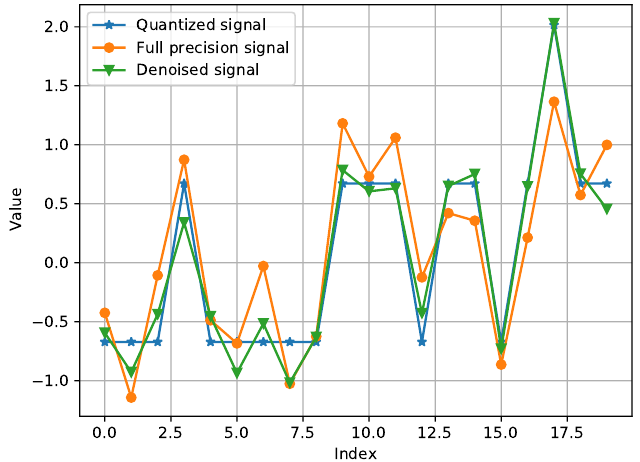
Figure 9. The denoised signals are compared with the full precision signal.